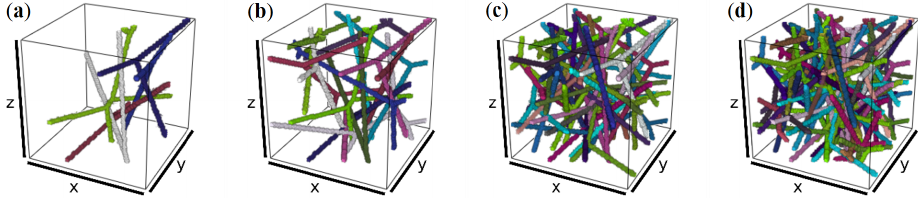
Figure 11. Rotated, superposed 2D network realizations forming a 3D network in images of 100 3 voxels. λ = 10/400 2 . Varying ν yields varying solid fiber volume rates (VR): ( a ) ν = 5, VR = 1%; ( b ) ν = 15, VR = 3%; ( c ) ν = 32, VR = 7%; ( d ) ν = 45, VR =